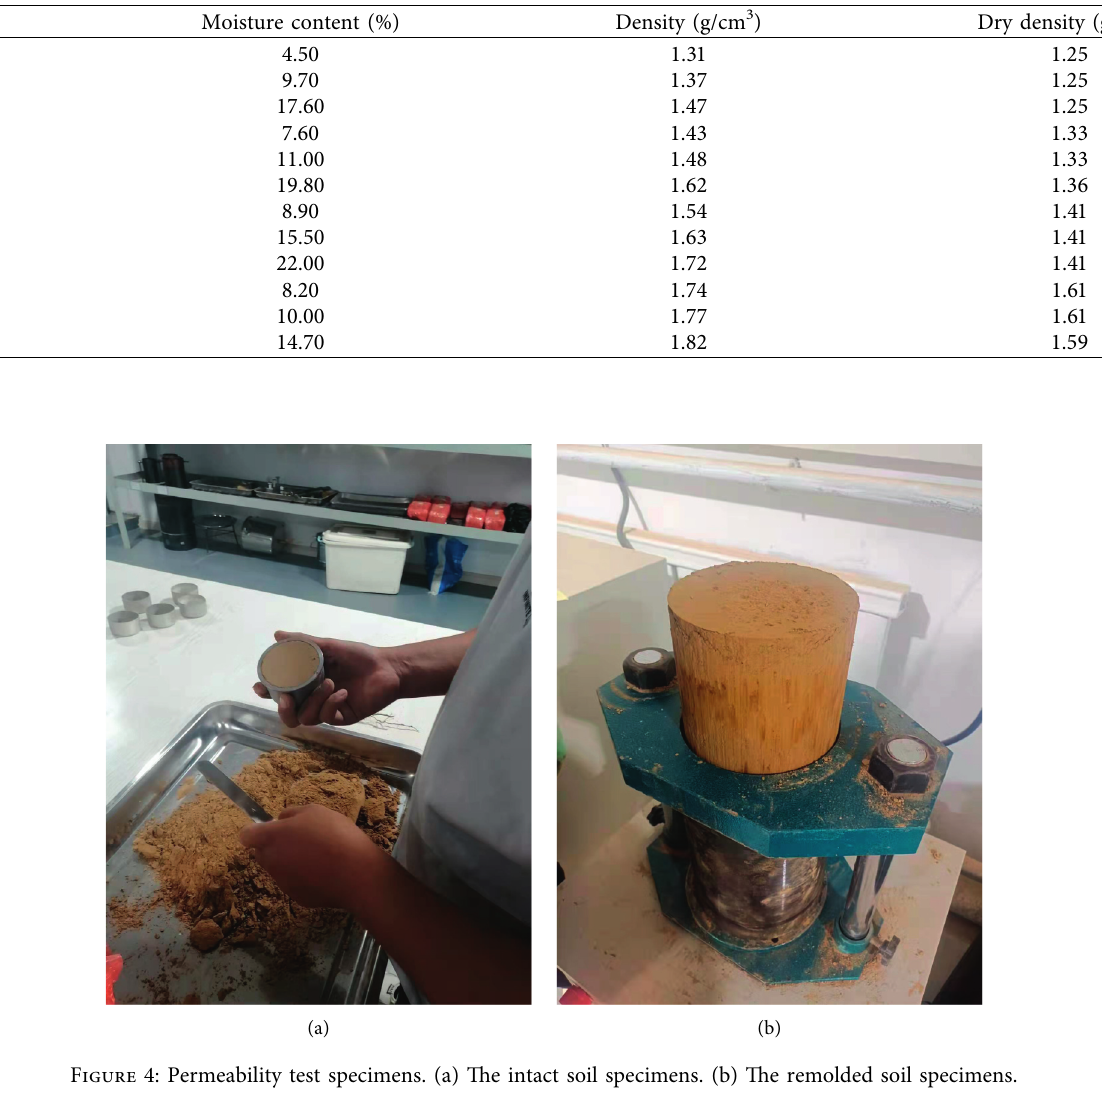
Figure 3: Soil particle size distribution. Table 2: Grouping and parameters of remolded soil samples.